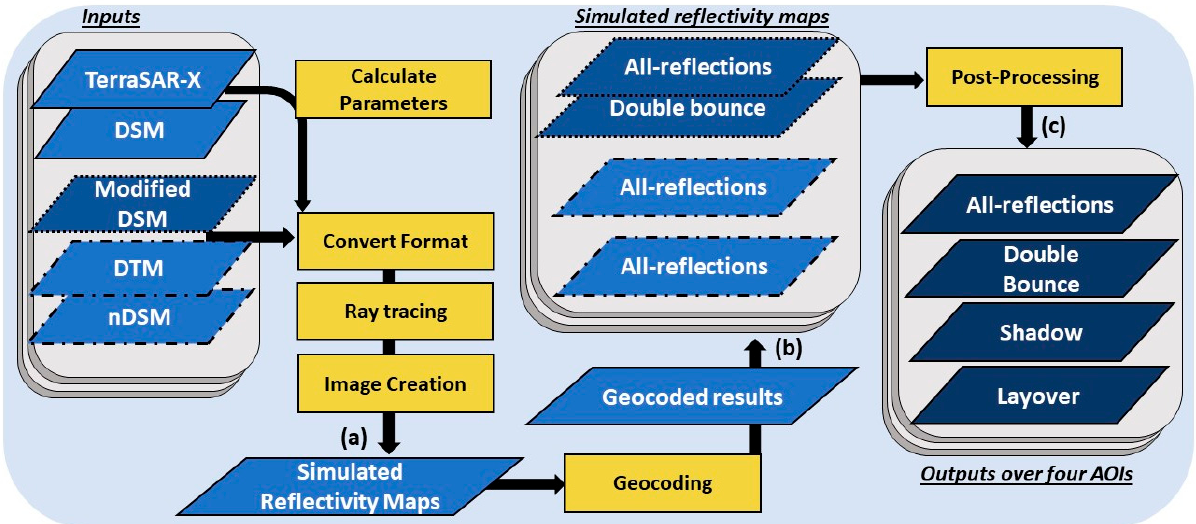
Figure 5. Processing chain of SAR simulation over four selected areas. Part ( a ) shows how to generate simulated reflectivity maps, and part ( b ) lists the geocoded results derived from part ( a ). The modified DSM in each area results in two geocoded features, double bounce, and all-reflections as shown in part ( b ); DTM and nDSM result in an all-reflections feature as shown in part ( b ). Part ( c ) represents the final SAR simulation features after being post-processed.